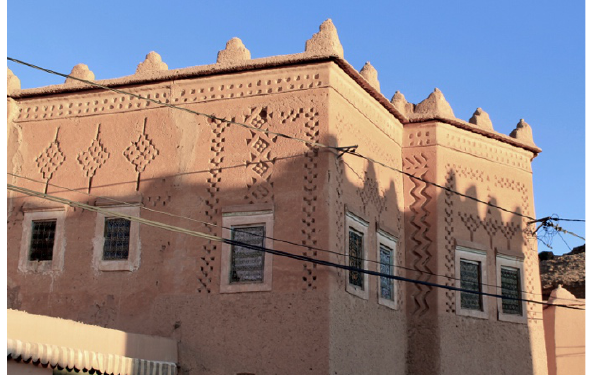
Figure 5. Engraved wall decoration near Kelaat M’Gouna.